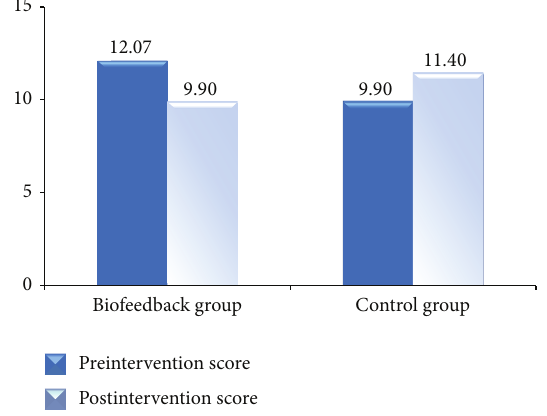
Figure 3: Pre- and postintervention mean scores for CES- Depression